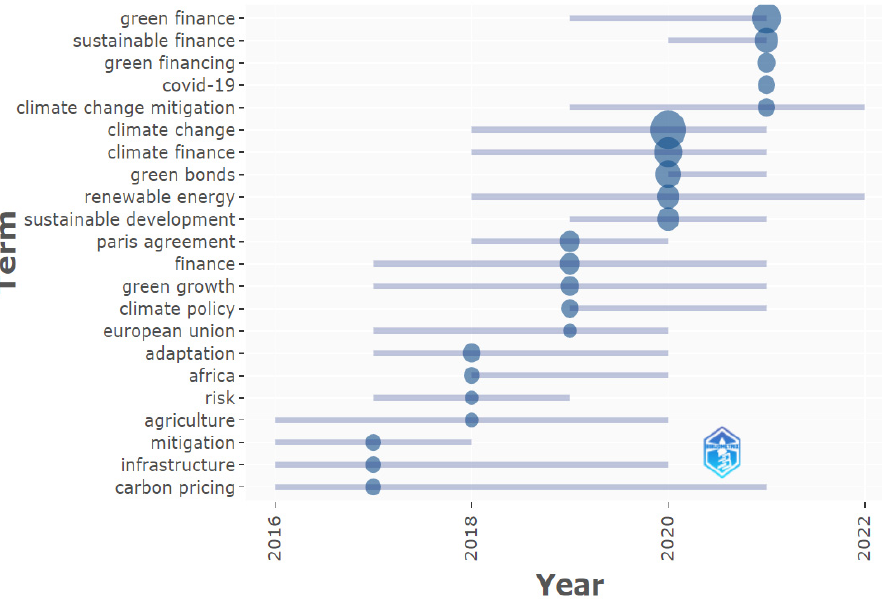
Figure 3. Trend topic based on author’s keywords. Source: Authors’ own compilation using Bibliometric R-package.